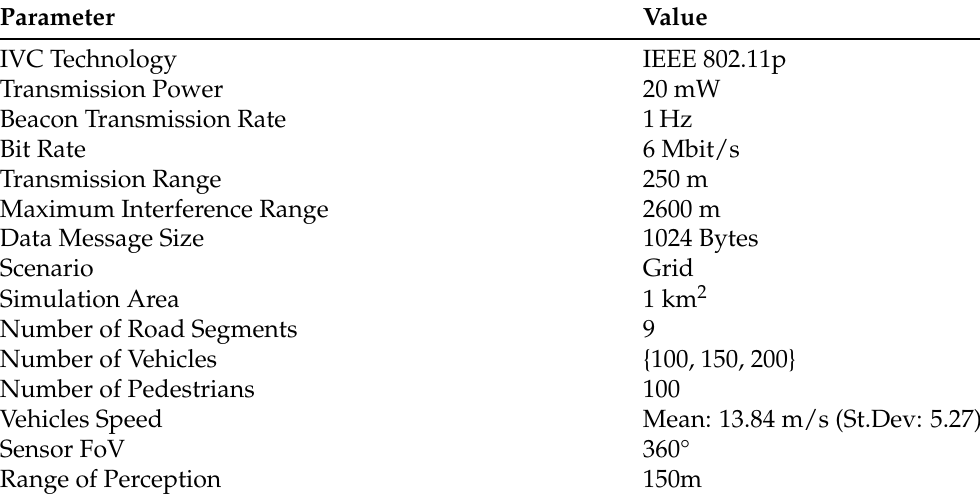
Table 1. Simulation